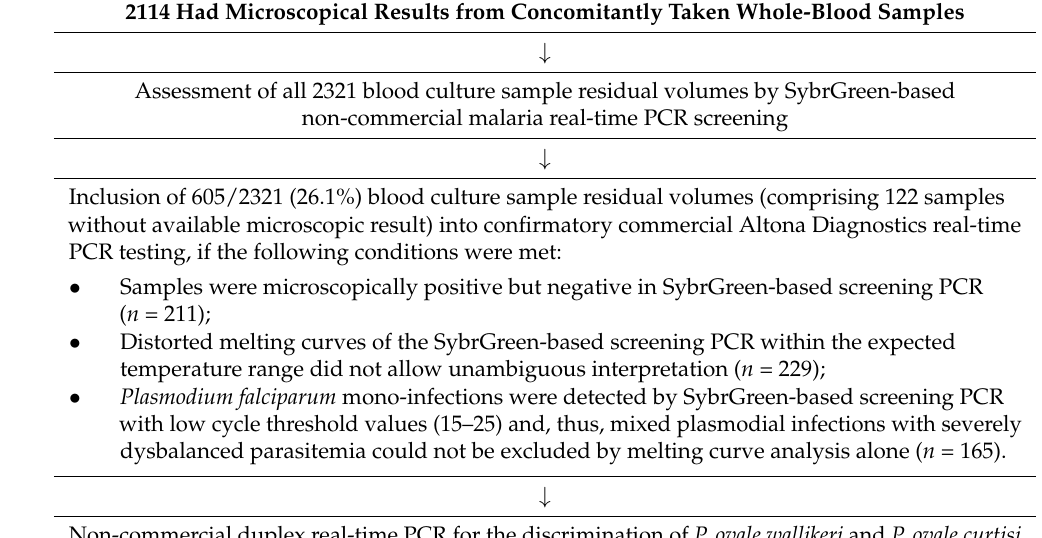
Table 2. Flow-chart indicating the diagnostic workflow with residual materials from incubated blood culture samples from a previous Ghanaian study [24–28] as detailed above in the “Materials and Methods” chapter. 2321 Blood Culture Samples from a Ghanaian Epidemiological Study Included, of